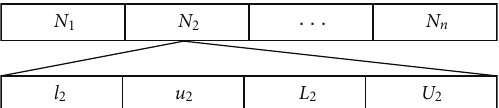
individual. And set the number of success of the optimal fitness individual as the highest so as to make sure the optimal individual stored in the situational